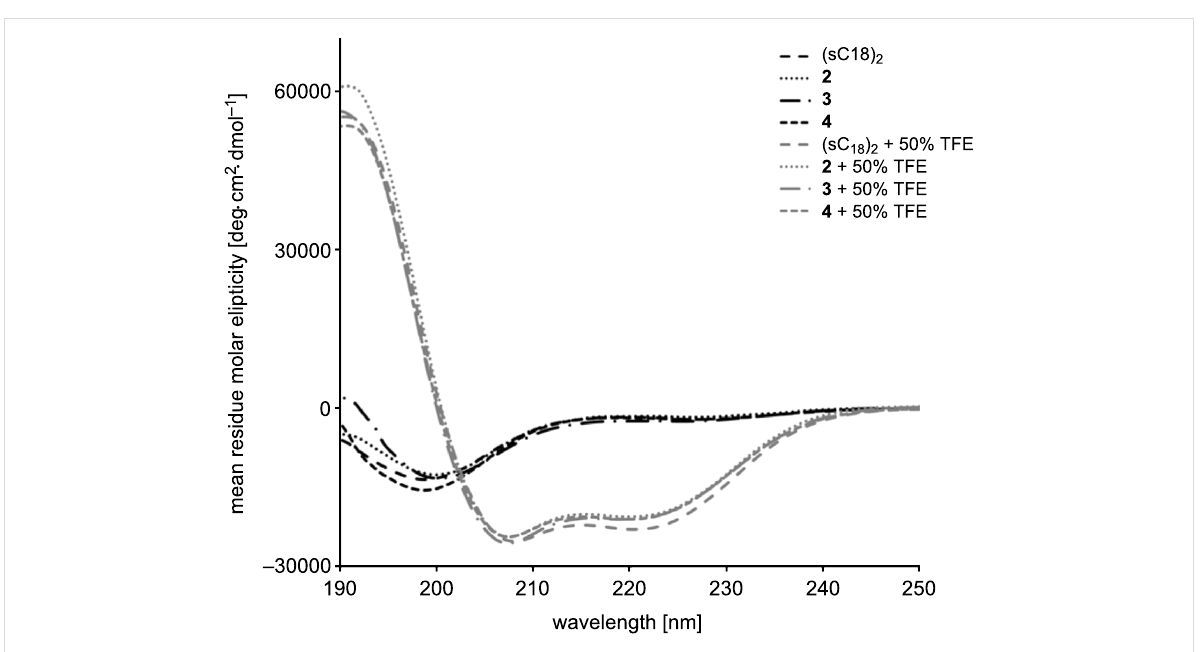
Figure 6: Circular dichroism spectra of the (sC18) 2 conjugates. Spectra were acquired in 10 mM phosphate buffer with or without 50% trifluoro- ethanol (TFE), as indicated.